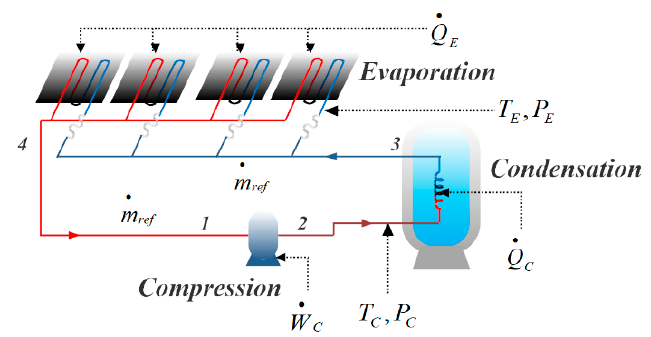
Figure 1. DXSAHP system diagram.